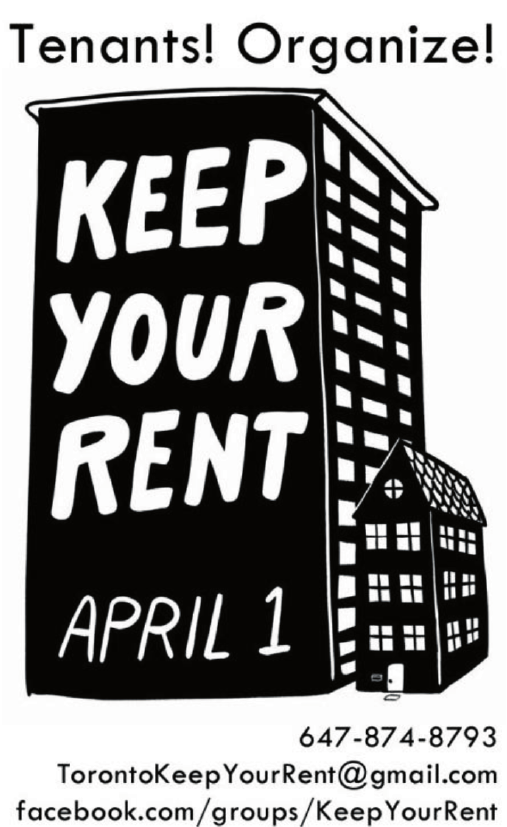
Figure 2. Keep Your Rent poster by artist Patterson Hodgson. Source: Keep Your Rent